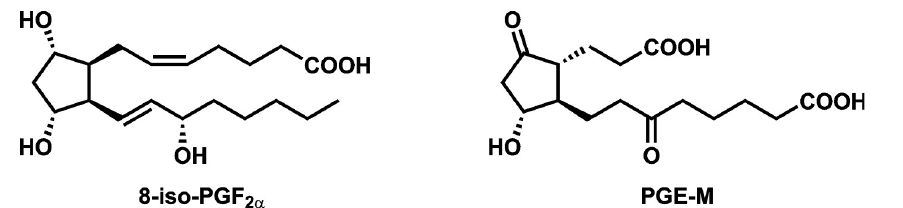
Fig 1. Structures of 8- iso -PGF 2 α and